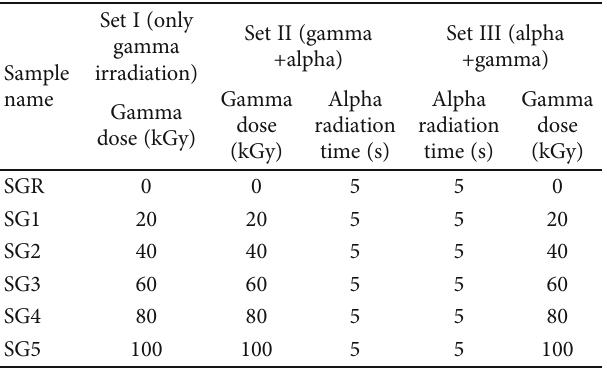
Table 1: Gamma irradiated sample details.